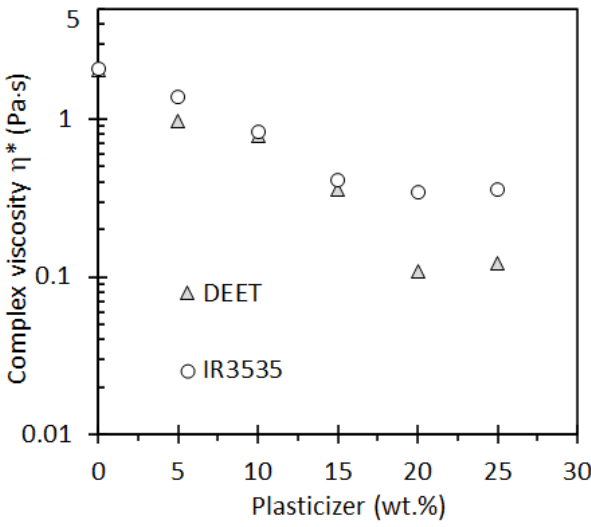
Figure 6. Variation of the complex viscosity with the concentration of the repellents DEET and IR3535. The plotted plateau values reflect measurements obtained at 200 ° C.